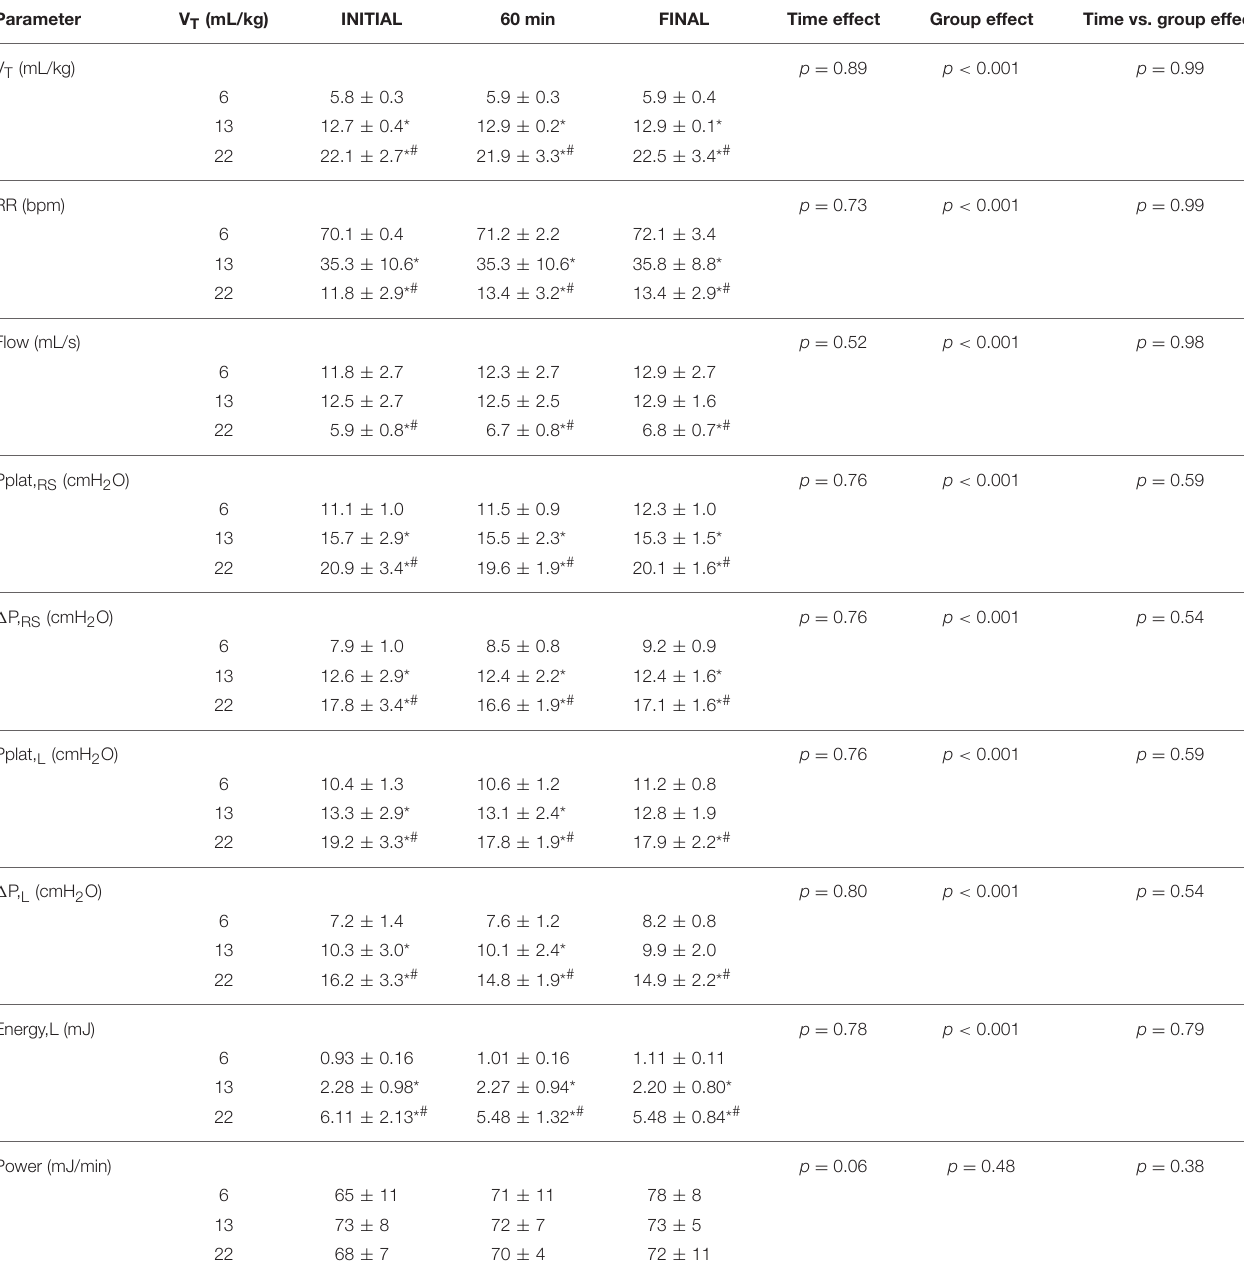
TABLE 1 | Respiratory parameters during mechanical ventilation. Parameter INITIAL 60 min FINAL Time effect Group